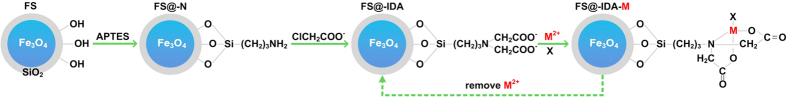
Schematic of the preparation and reprocessing of FS@IDA for the chelation and removal of heavy metal ions (M2+).FS, Fe3O4@SiO2; APTES, γ-aminopropyltriethoxysilane; FS@-N, surface-aminated FS; FS@IDA, magnetic solid trimethylene iminodiacetic acid chelator; FS@IDA-M, magnetic solid chelate complex; M2+, divalent heavy metal ion.